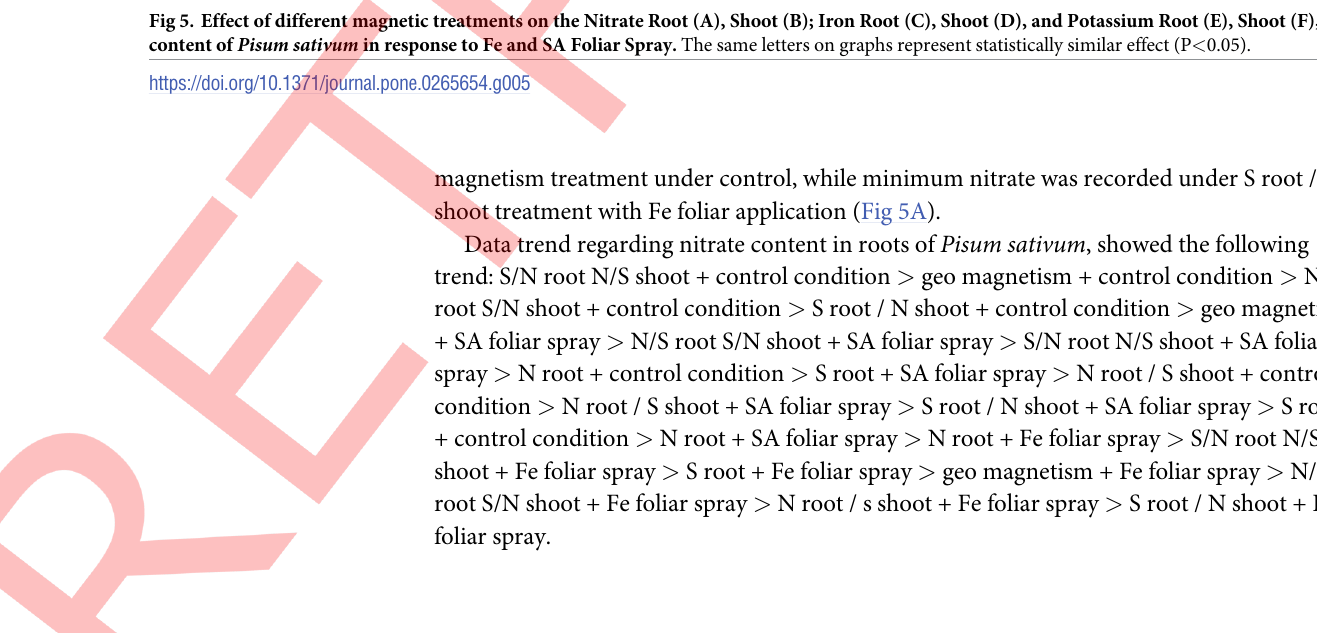
PLOS ONE | https://doi.org/10.1371/journal.pone.0265654 April 14,